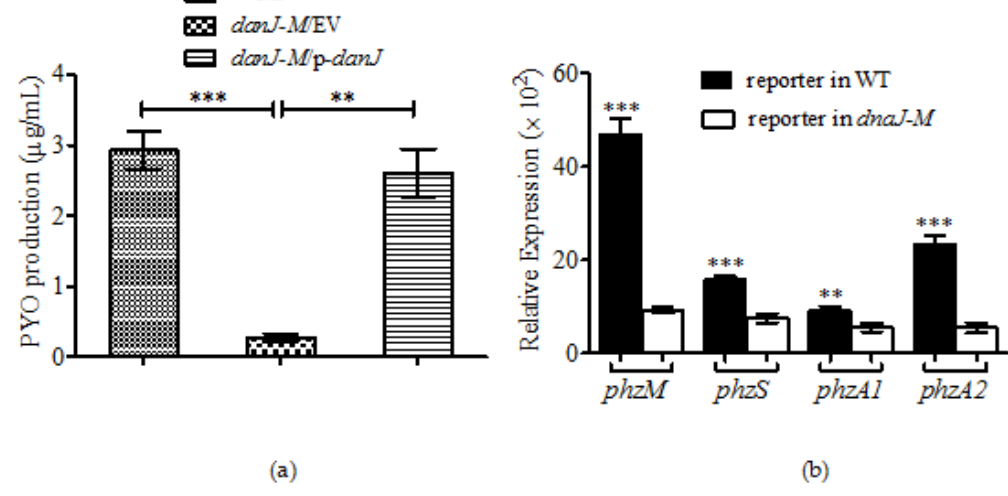
Figure 2. Comparison of pyocyanin production and expression of related genes in the wild-type dnaJ mutant and the complementation strains. ( a ) Reduced production of pyocyanin in dnaJ-M . The means of three independent experiments are shown. ( b ) The expression of phzM , phzS , phzA1 and phzA2 using p- lux promoter-reporter systems in the wild-type (black) and the dnaJ-M (white) strains. The values are presented as cps normalized to OD 600 . Data shown are averages from triplicate experiments ± standard errors. A two-tailed unpaired t -test was performed using GraphPad software version 5.0 (** p < 0.01; *** p < 0.001). The results shown are representative of three independent experiments with similar